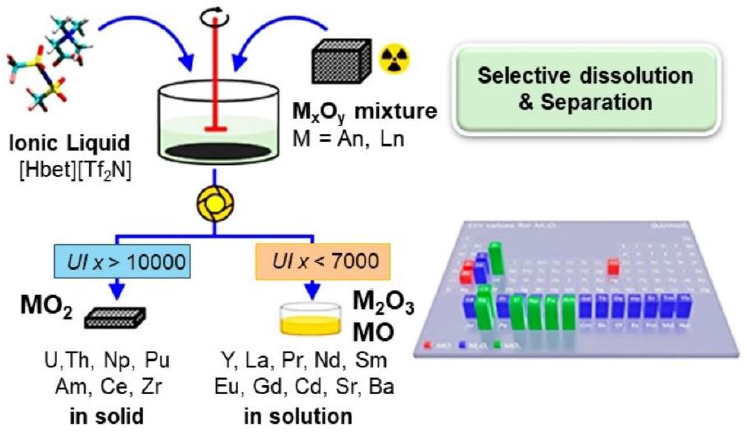
Figure 8. Schematic representation of selective dissolution and separation of fission products with help of carboxyl-functionalized ionic liquid, [Hbet][Tf 2 N]. “Reprinted (adapted) with permission from Fan, F. L.; Qin, Z.; Cao, S. W.; Tan, C. M.; Huang, Q. G.; Chen, D. S.; Wang, J. R.; Yin, X. J.; Xu,